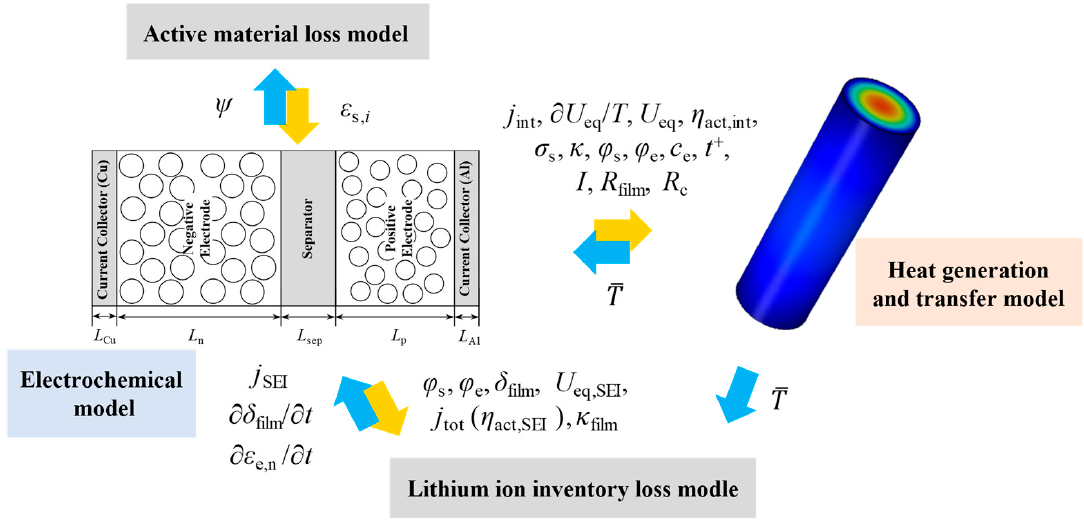
Figure 2. Coupling relationship between submodels.